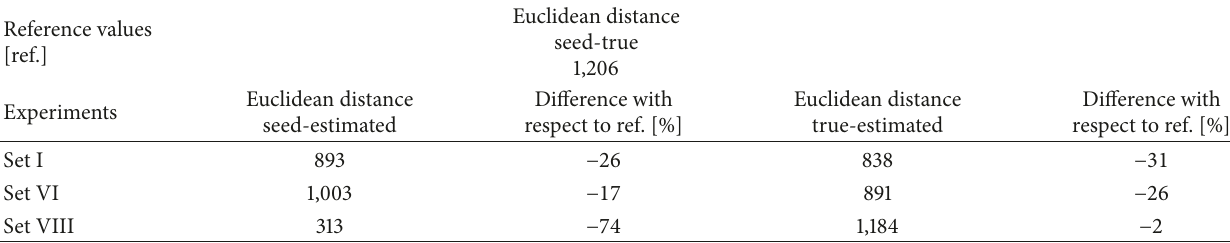
Table 9: Evaluation of the estimated demand in terms of O–D distribution in space (adding O-D travel times). Reference values